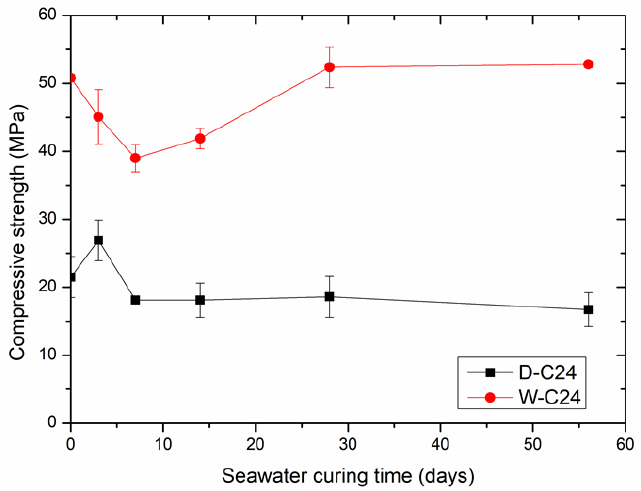
Figure 6. The effects of seawater curing time on the compressive strength of carbonated compacts made from SSD (D-C24) and SSW made from SSD (D-C24) and SSW (W-C24).